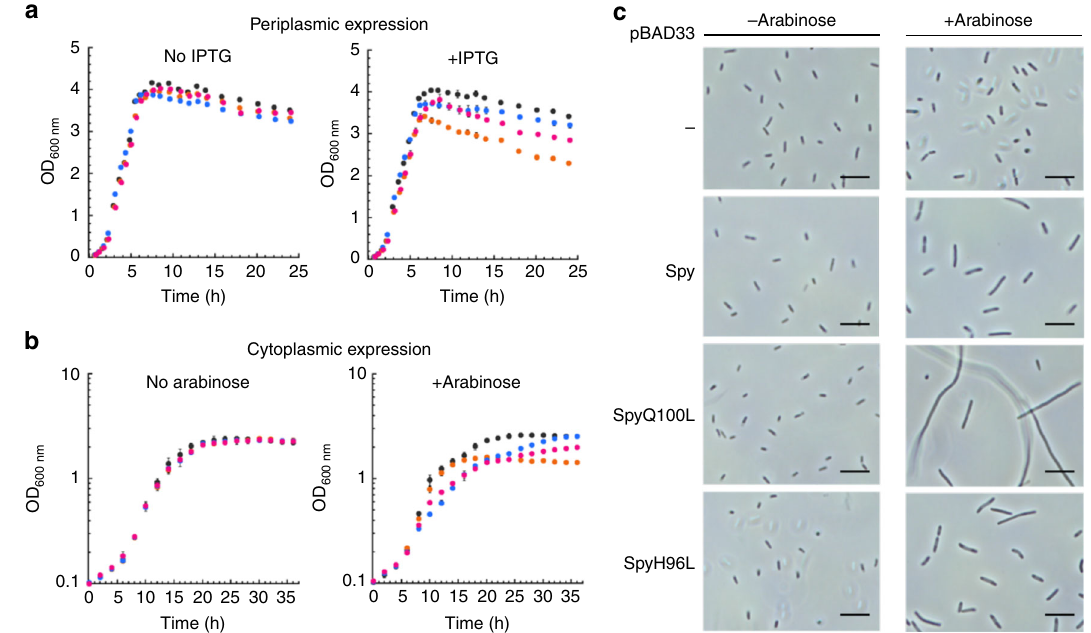
Fig. 6 Physiological effect of overexpression of Spy and its variants (Q100L and H96L) on E. coli growth curve. Spy (pink) and its variants (SpyH96L: blue; SpyQ100L: orange) were overexpressed in the periplasm of E. coli (a) and in the cytoplasm of E. coli (b) . The black arrow in the curves on the right indicates the time point of adding inducer (IPTG or arabinose). c Cell morphology of E. coli expressing Spy and its variants (scale bar 10 µ